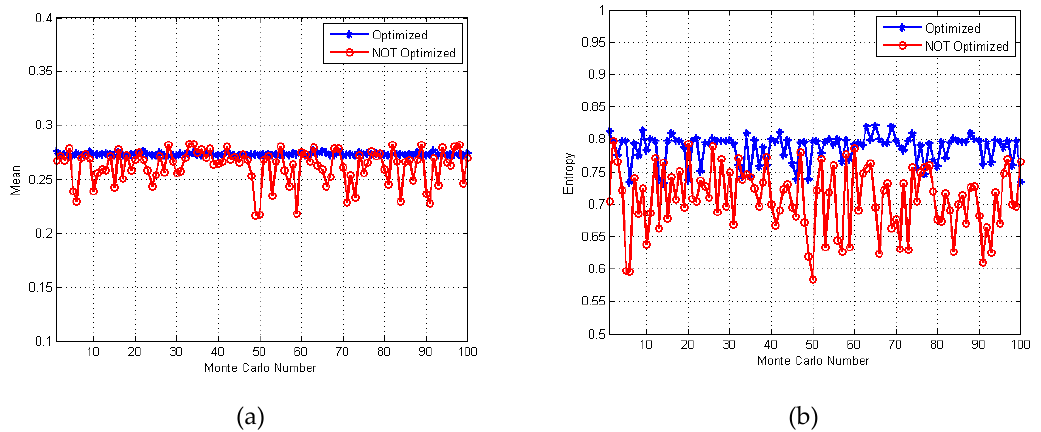
Figure 20. Monte Carlo results of MPSM jamming for the optimized phase situation: ( a ) mean values; ( b ) entropy values.